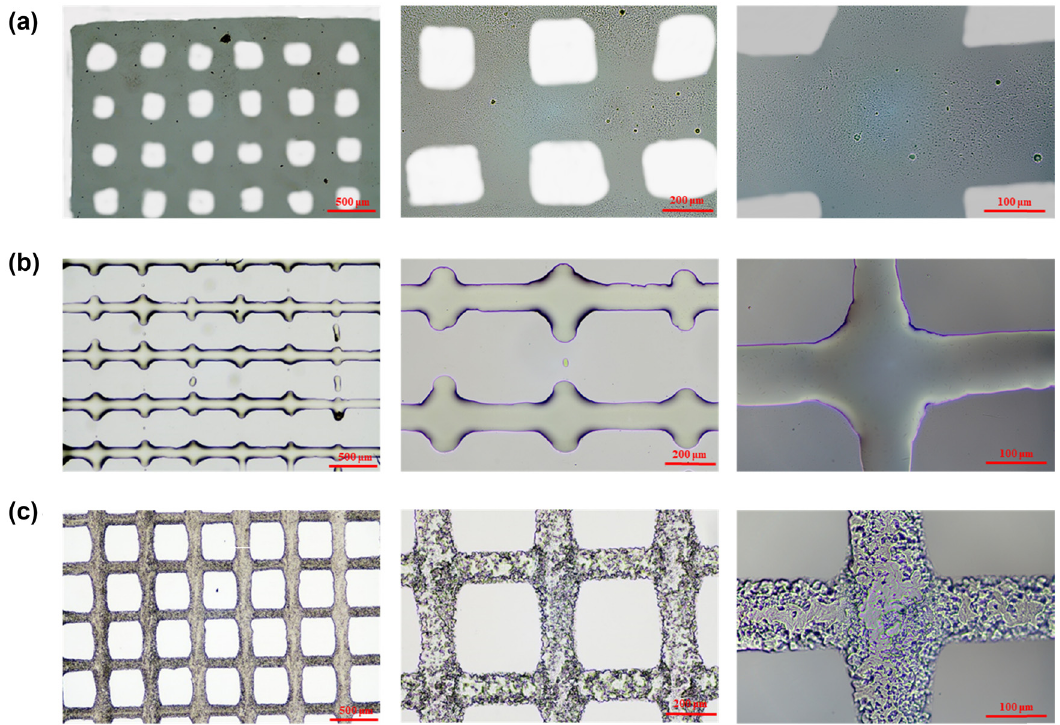
Figure 4: Morphology of ( a ) HAMA - gel, ( b ) PEGDA, and ( c ) PCEC - derived micropatterns by inkjet printing. The scales are 500, 200, and 100 µm,